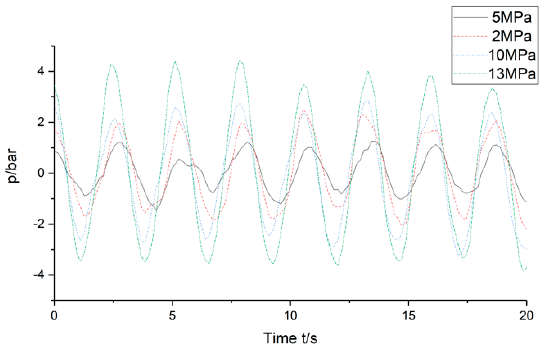
Figure 13. Experimental pressure output curve of accumulator under different inflation pressures.